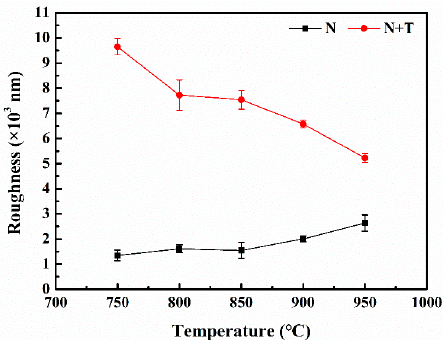
Figure 2. Surface roughness and three-dimensional morphology of titanium alloy samples after nitriding and nitriding/texturing combined treatment at different temperatures.